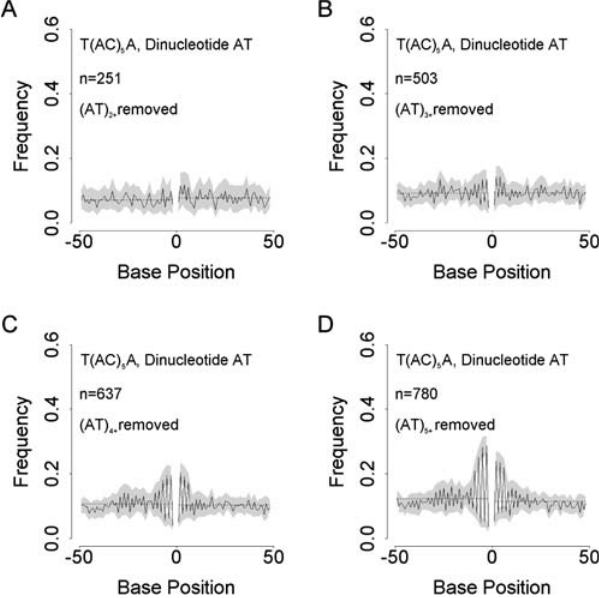
Figure 6. Dependence of Dinucleotide Pattern Strength on the Presence of Repeat Clusters Beginning with the dataset from the scenario showing strong patterning and large sample size (cassette T/A, dinucleotide AT, (AC) 5 ; see Figure 5C), flanking sequences containing (AT) x were excluded, where x equalled 2 or more (A), 3 or more (B), 4 or more (C), and 5 or more (D). Plotting conventions are the same as for Figure 4. DOI: 10.1371/journal.pbio.0020199.g006